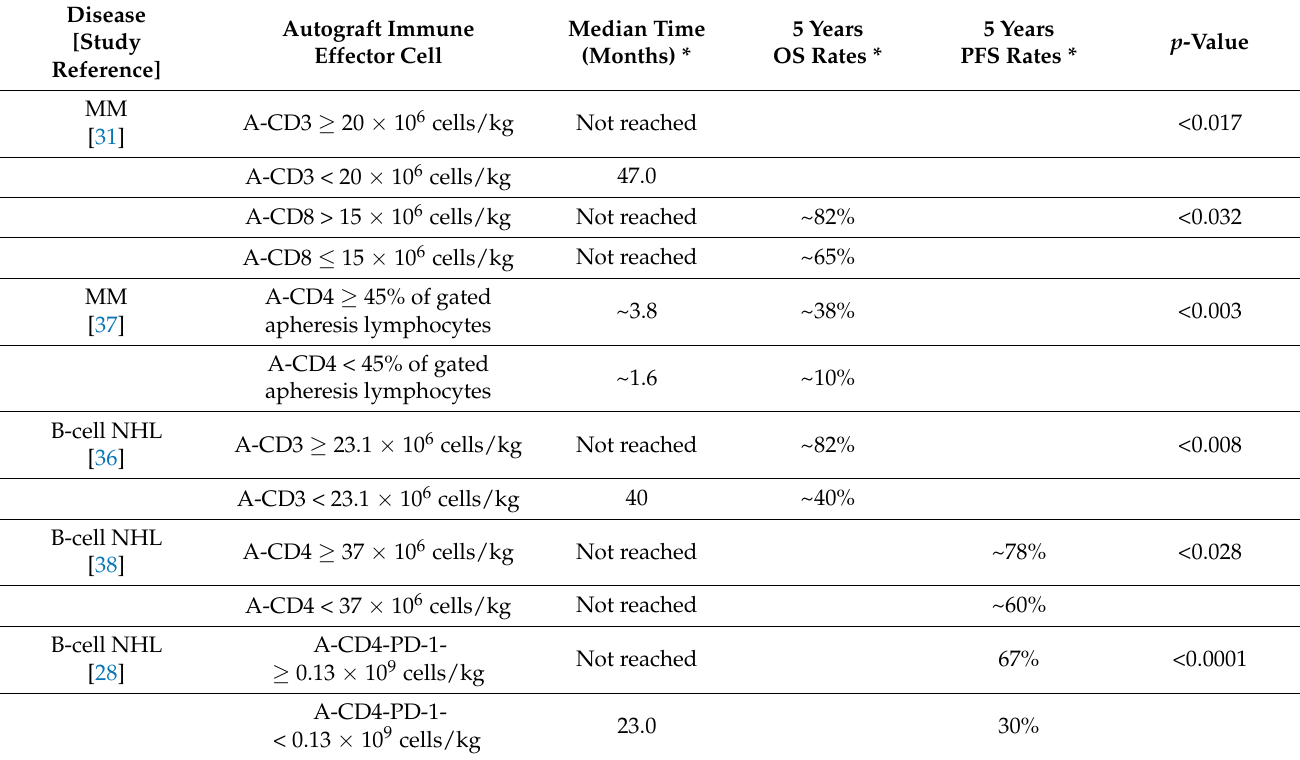
Table 4. Clinical outcomes post-autologous stem cell transplantation based on the infusion of autograft-adaptive immune